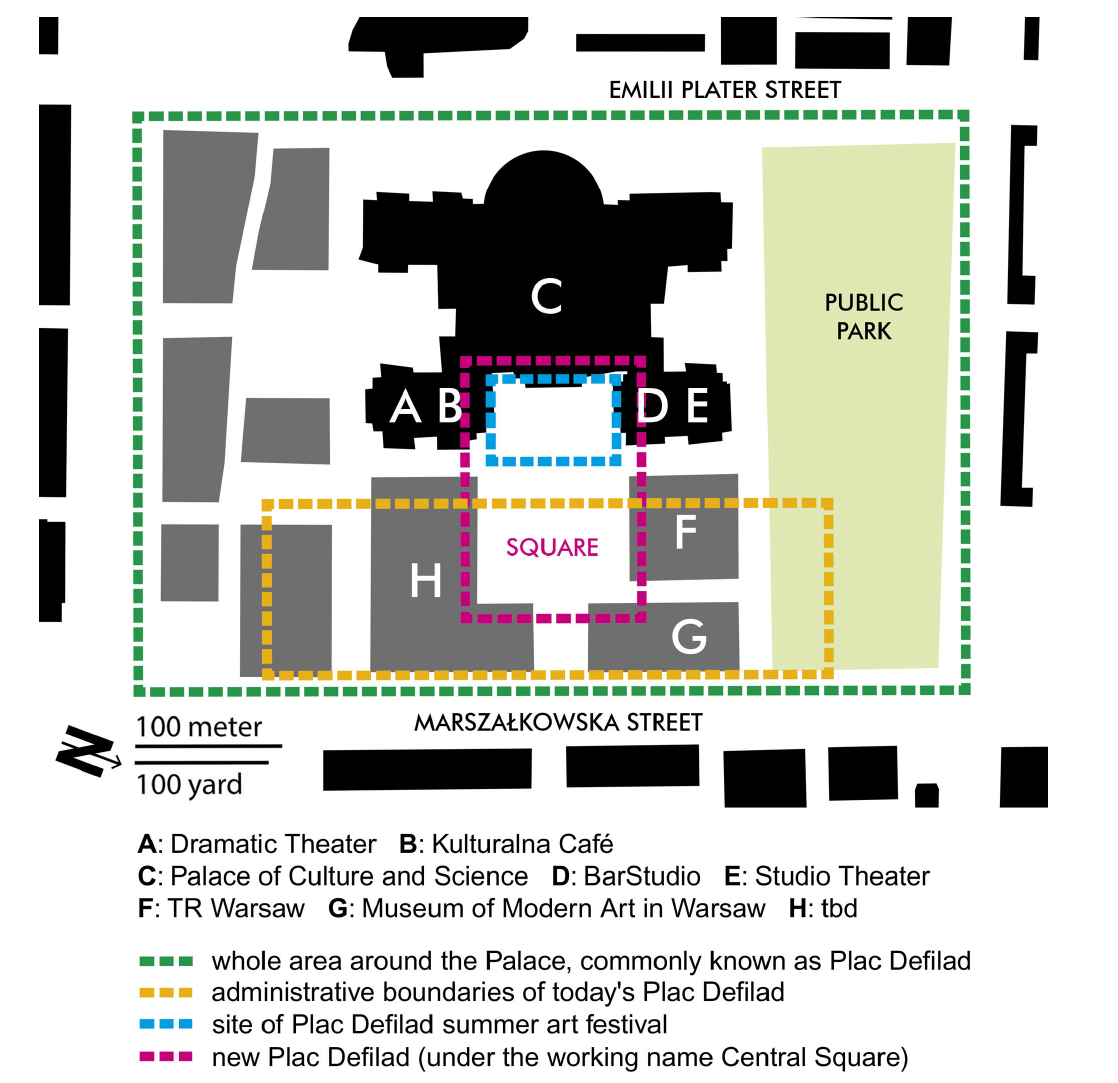
Fig. 3 . Local institutions have collaborated in transforming Plac Defilad (Parade Square) since 2014. The picture depicts the participants (letters), future developments as provided by the current zoning (grey shapes), and different jurisdictional boundaries (dashed